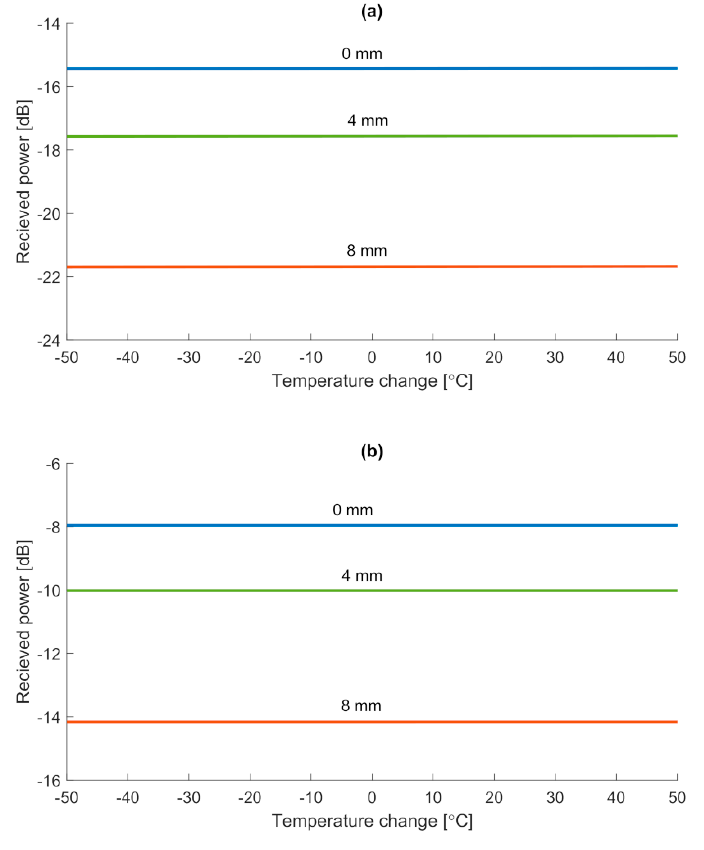
Figure 4. Received power versus the ambient temperature change of the grating for several values of grating length. The central wavelength of the SLED ( a ) is mutually shifted by 20 nm and ( b ) corresponds to the central wavelength of the grating. Initial Bragg grating length is assumed to be 10